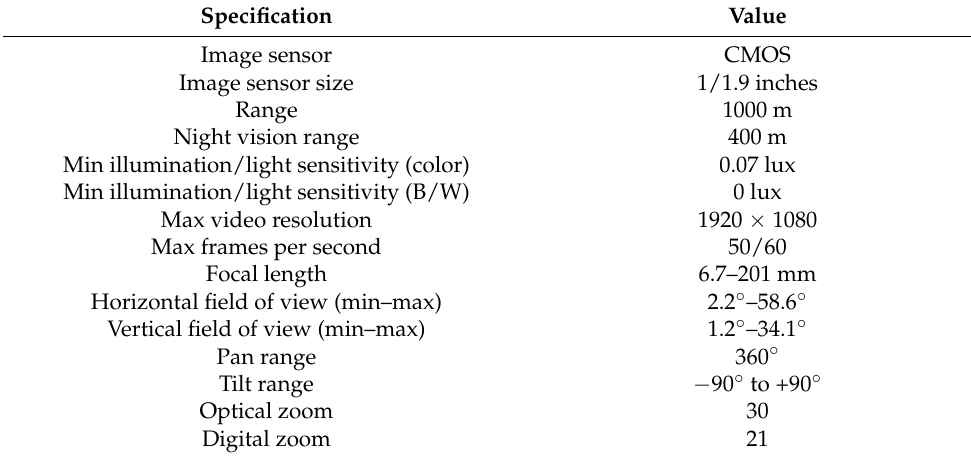
Table 9. Axis Q6215-LE PTZ specifications.